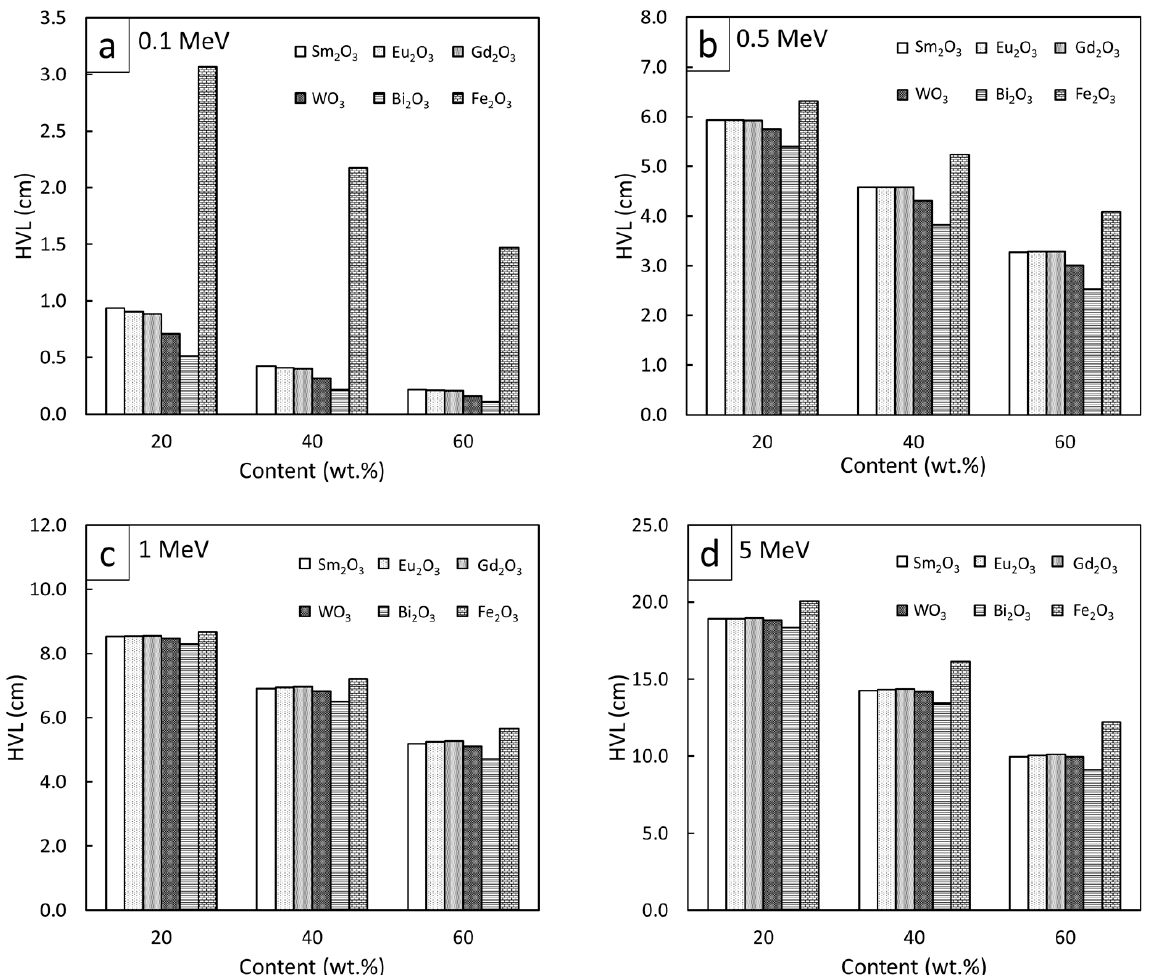
Figure 9. Comparative HVL values of Sm 2 O 3 /HDPE, Eu 2 O 3 /HDPE, and Gd 2 O 3 /HDPE composites with other common Pb-free HDPE composites (Bi 2 O 3 /HDPE, WO 3 /HDPE, and Fe 2 O 3 /HDPE) at filler contents of 20, 40, and 60 wt.% and photon energies of ( a ) 0.1 MeV, ( b ) 0.5 MeV, ( c ) 1 MeV, and ( d ) 5 MeV.